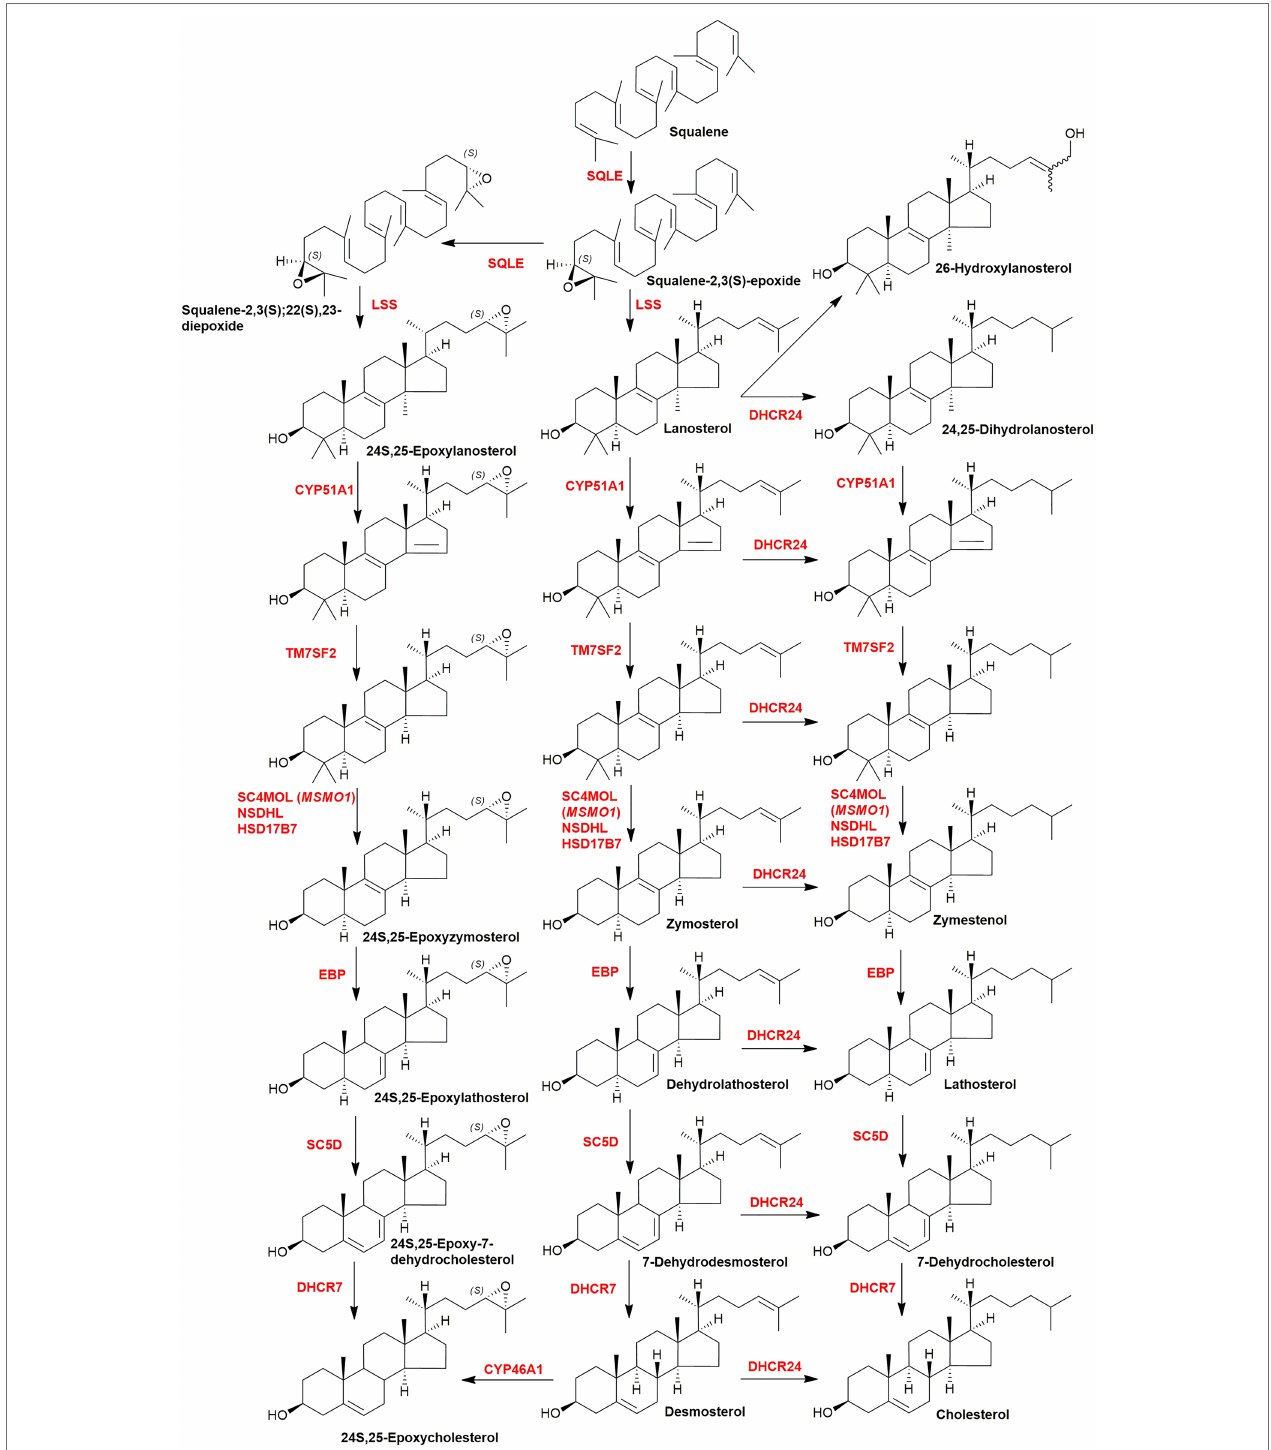
FIGURE 6 | Pathway from squalene to cholesterol and 24S,25-epoxycholesterol. Enzymes are indicated in